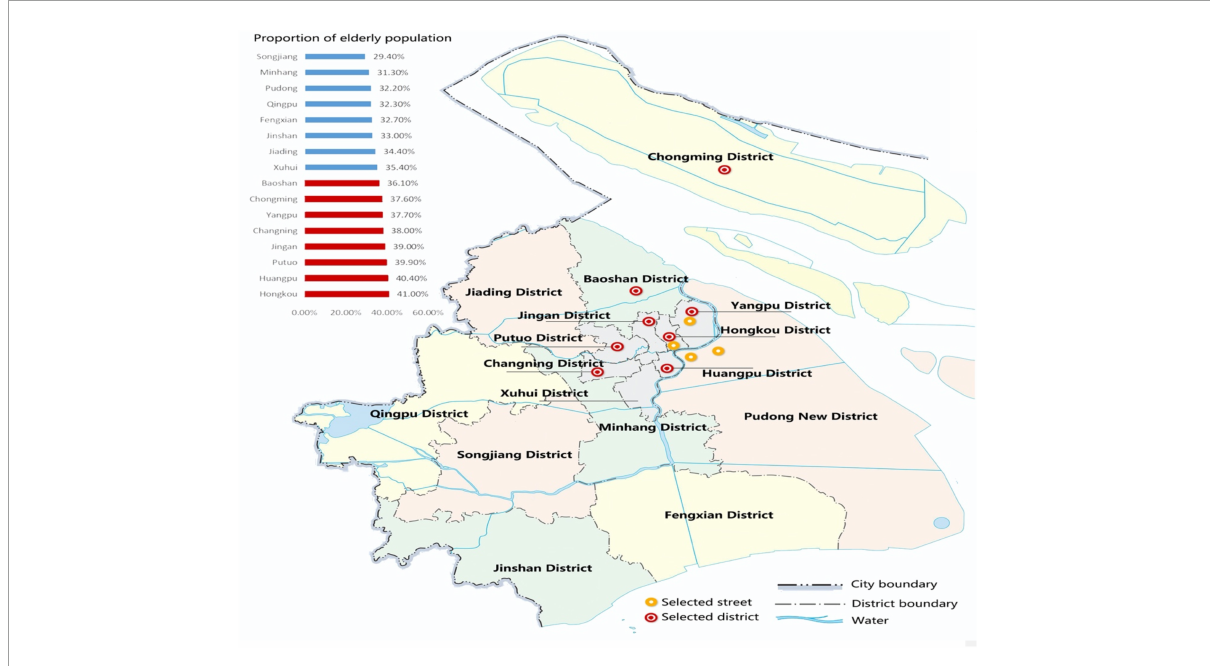
FIGURE3 Study area and basic geographical and demographic information [Source: Zhu et al.